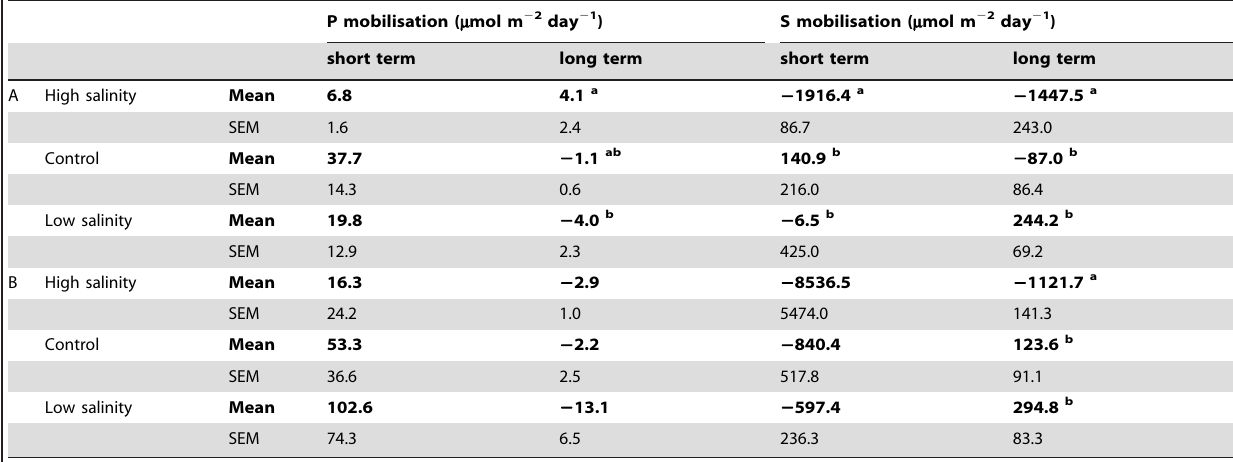
Significant differences between treatments are indicated by different letters.